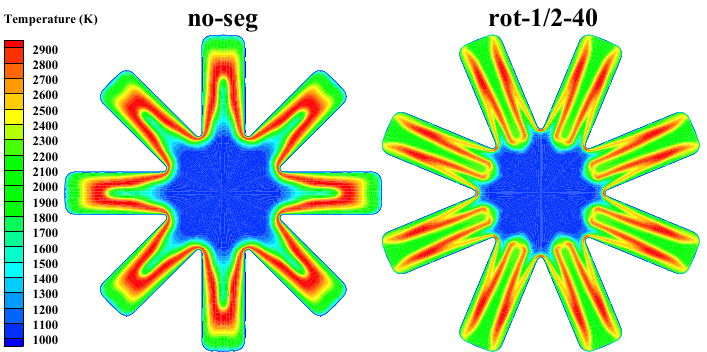
that the flame is closer to the fuel wall at the star root (point a in Figure 2), and it is thinner